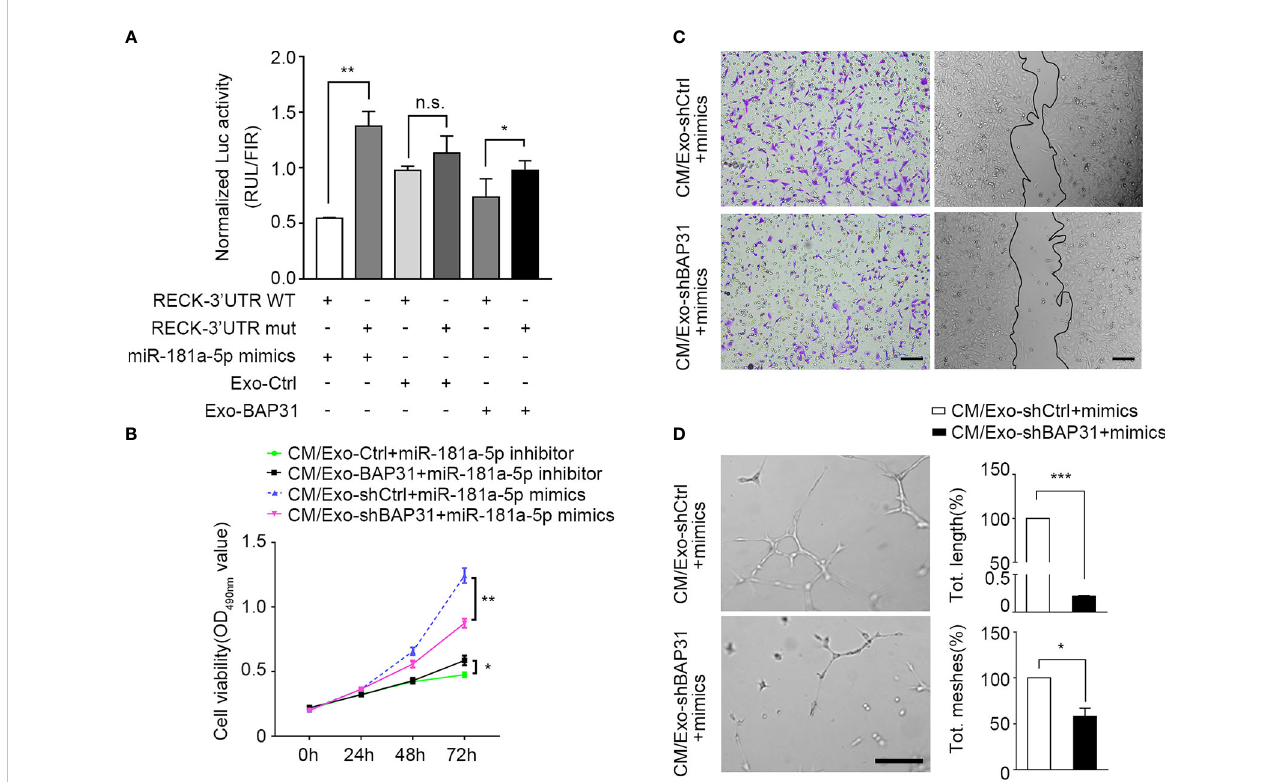
FIGURE 5 BAP31 promoted fi broblast activation via exosomal miR-181a-5p. Fibroblasts were transfected with miR-181a-5p mimics or treated by exosomes from CRCs. (A) Luciferase activities reporter shows the binding effect of miR-181a-5p and BAP31-induced CRC exosomes to the RECK 3 ′ -UTR. Mean ± SEM are provided (n = 3). * p < 0.05 and ** p < 0.01; n.s., non-signi fi cance. The endothelial cells were treated by the conditioned medium from the fi broblasts. (B) MMT assay shows the endothelial cells proliferation. Mean± SEM are provided (n = 3). * p < 0.05 and ** p < 0.01. (C) Transwell and wound healing assays show the endothelial cells migration. Scale bar, 100 m m. (D) Tube formation assay shows the endothelial cells angiogenesis. Scale bar, 100 m m. Mean ± SEM are provided (n = 3). * p < 0.05 and *** p <